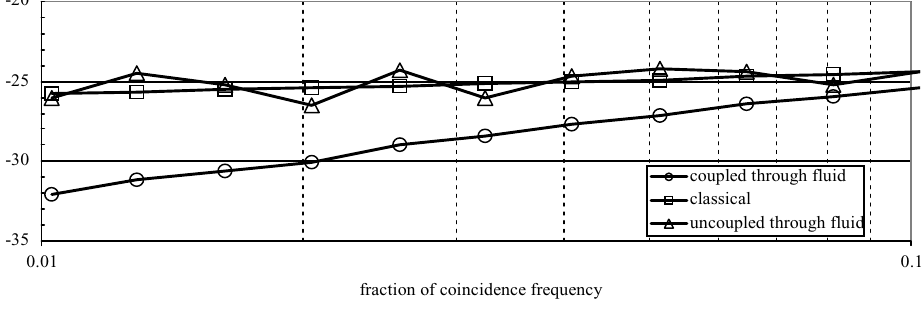
Fig. 4. Radiation efficiency of simply supported strip plate.